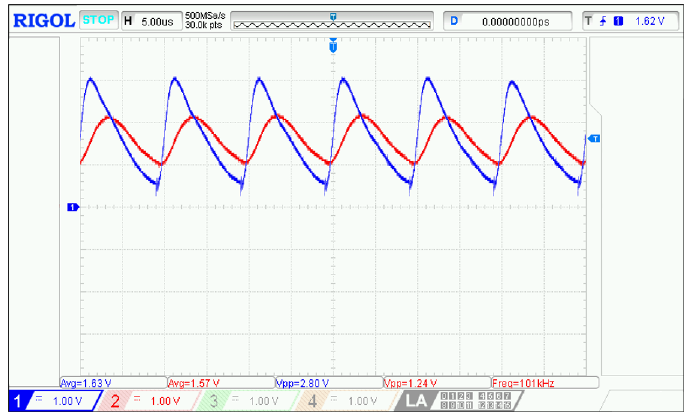
Figure 22. Control signals in the optimized